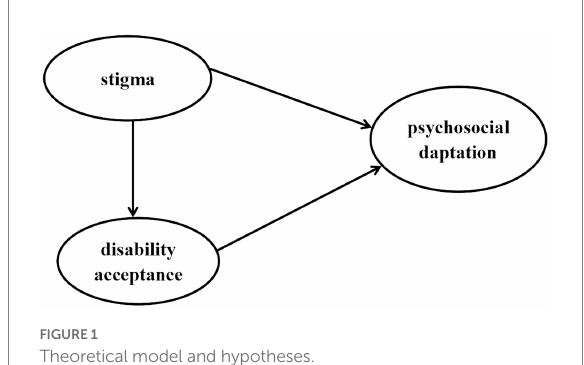
FIGURE 1 Theoretical model and